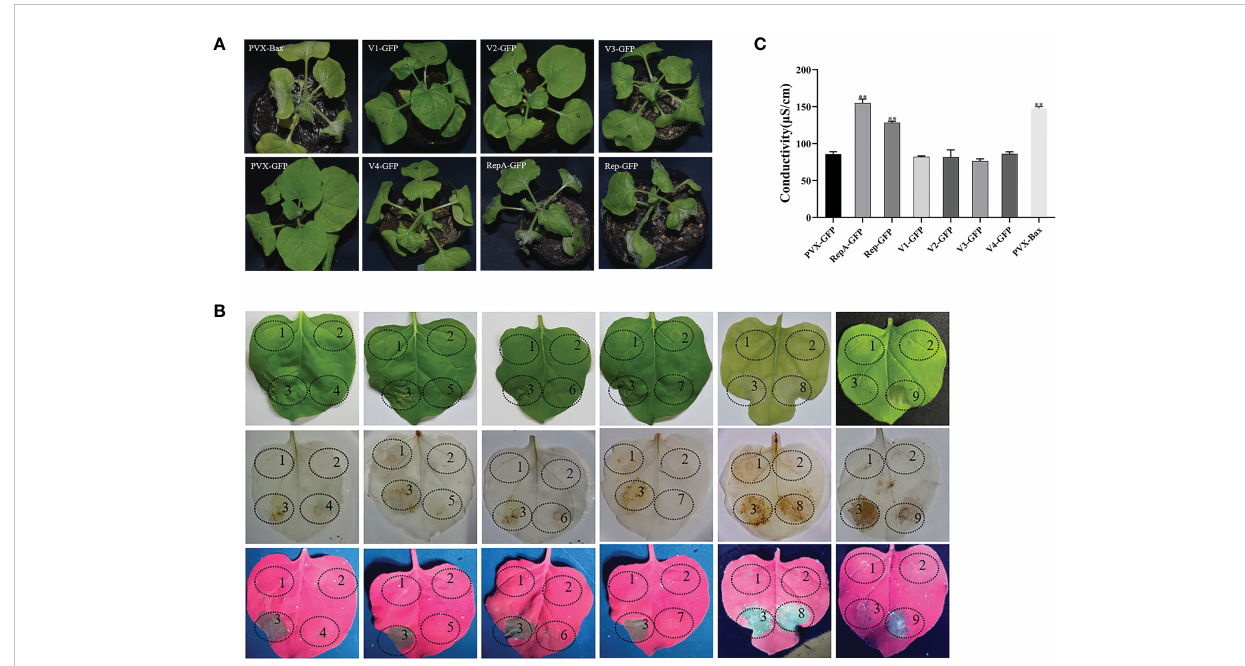
FIGURE 1 Identi fi cation of cell death induced by CCDaV-encoded proteins in Nicotiana benthamiana . (A) Disease symptoms observed in N. benthamiana leaves in fi ltrated with PVX-Bax, PVX-GFP, or recombinant PVX-GFP vectors expressing individual CCDaV proteins at 5 days post-in fi ltration (dpi). (B) CCDaV-encoded proteins transiently expressed in N. benthamiana . Photos were taken under white light (top panels); after 3,3 ′ -diaminobenzidine staining (middle panels); and under ultraviolet light at 5 dpi (bottom panels). 1, PVX-GFP; 2, Buffer; 3, PVX-Bax; 4, V1-GFP; 5, V2-GFP; 6, V3-GFP; 7, V4-GFP; 8, RepA-GFP; 9, Rep-GFP. (C) Conductivity detection at 3 dpi. Signi fi cant differences (** p < 0.01) were determined by Student ’ s t test. Each experiment was repeated four times with at least six independent biological